Question: Compose a caption that would accompany this figure in a paper.
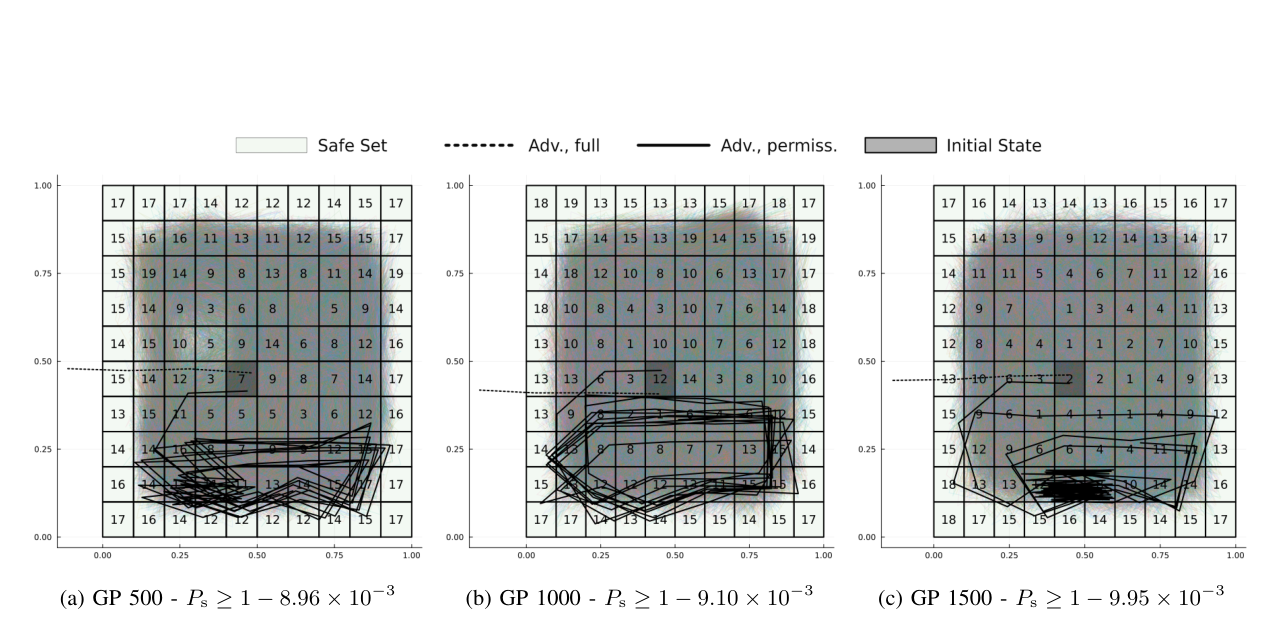
Answer: Results for the nonlinear system case studies using various sizes of datasets. Regions with # of removed control regions and simulated trajectories over 100 steps are shown in each plot. Adversarial trajectories show permissible control sets maintain safety.